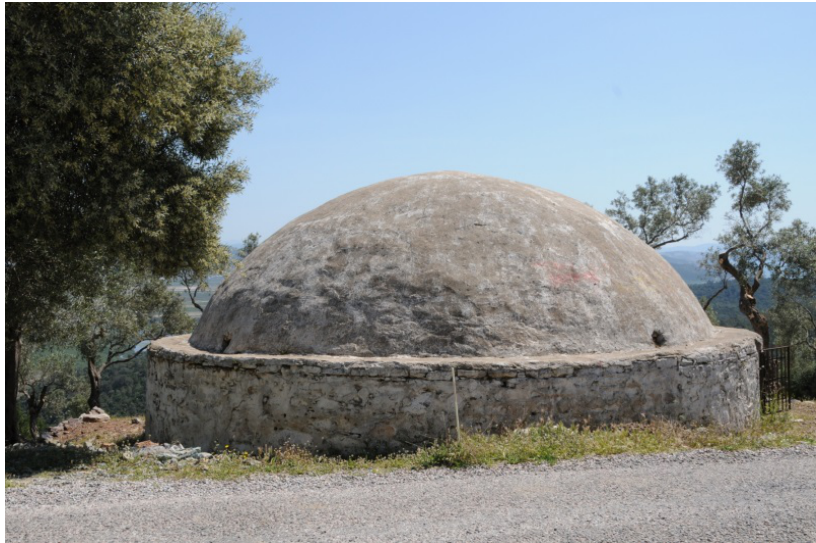
Figure 22. Ottoman cistern located near Bodrum, Turkey (photo copyright by L.W.